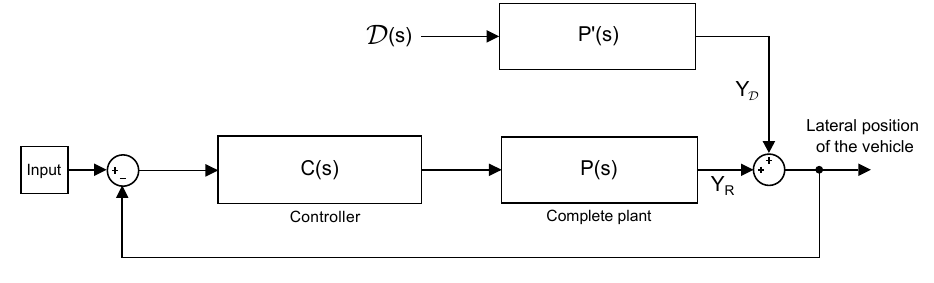
Figure 9. Closed-loop system with